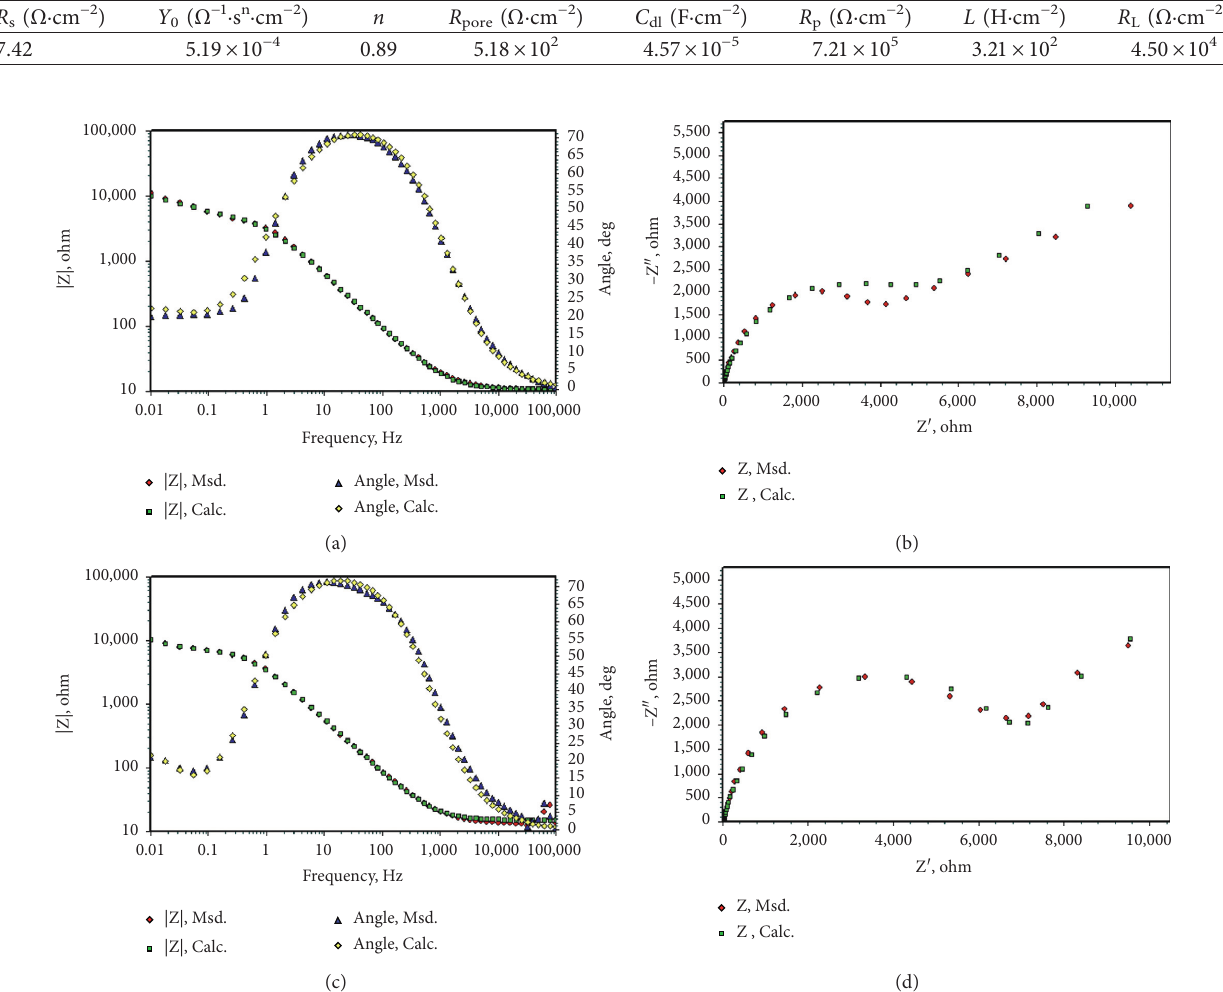
Figure 9: Equivalent circuit used to evaluate the EIS data presented in Figure 10 (Figure 9 is reproduced from [42] under the Creative Commons Attribution License/public domain). Table 3: Fitting results of the equivalent circuit obtained by fitting the EIS data.